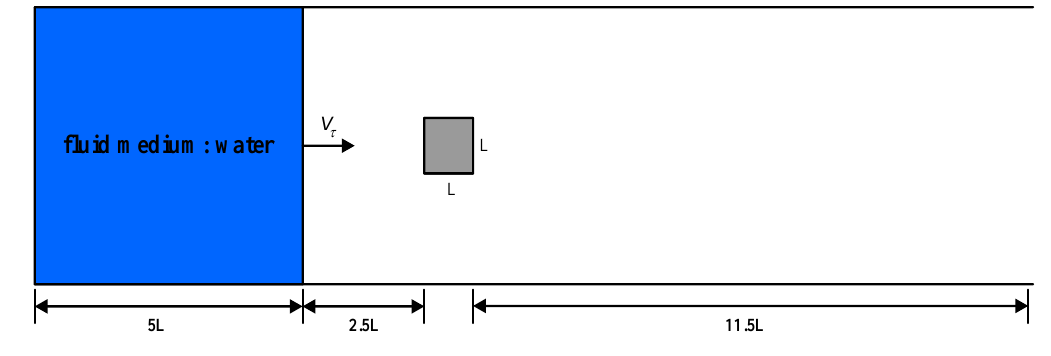
Fig. 9. The structure of flow around a square cylinder.